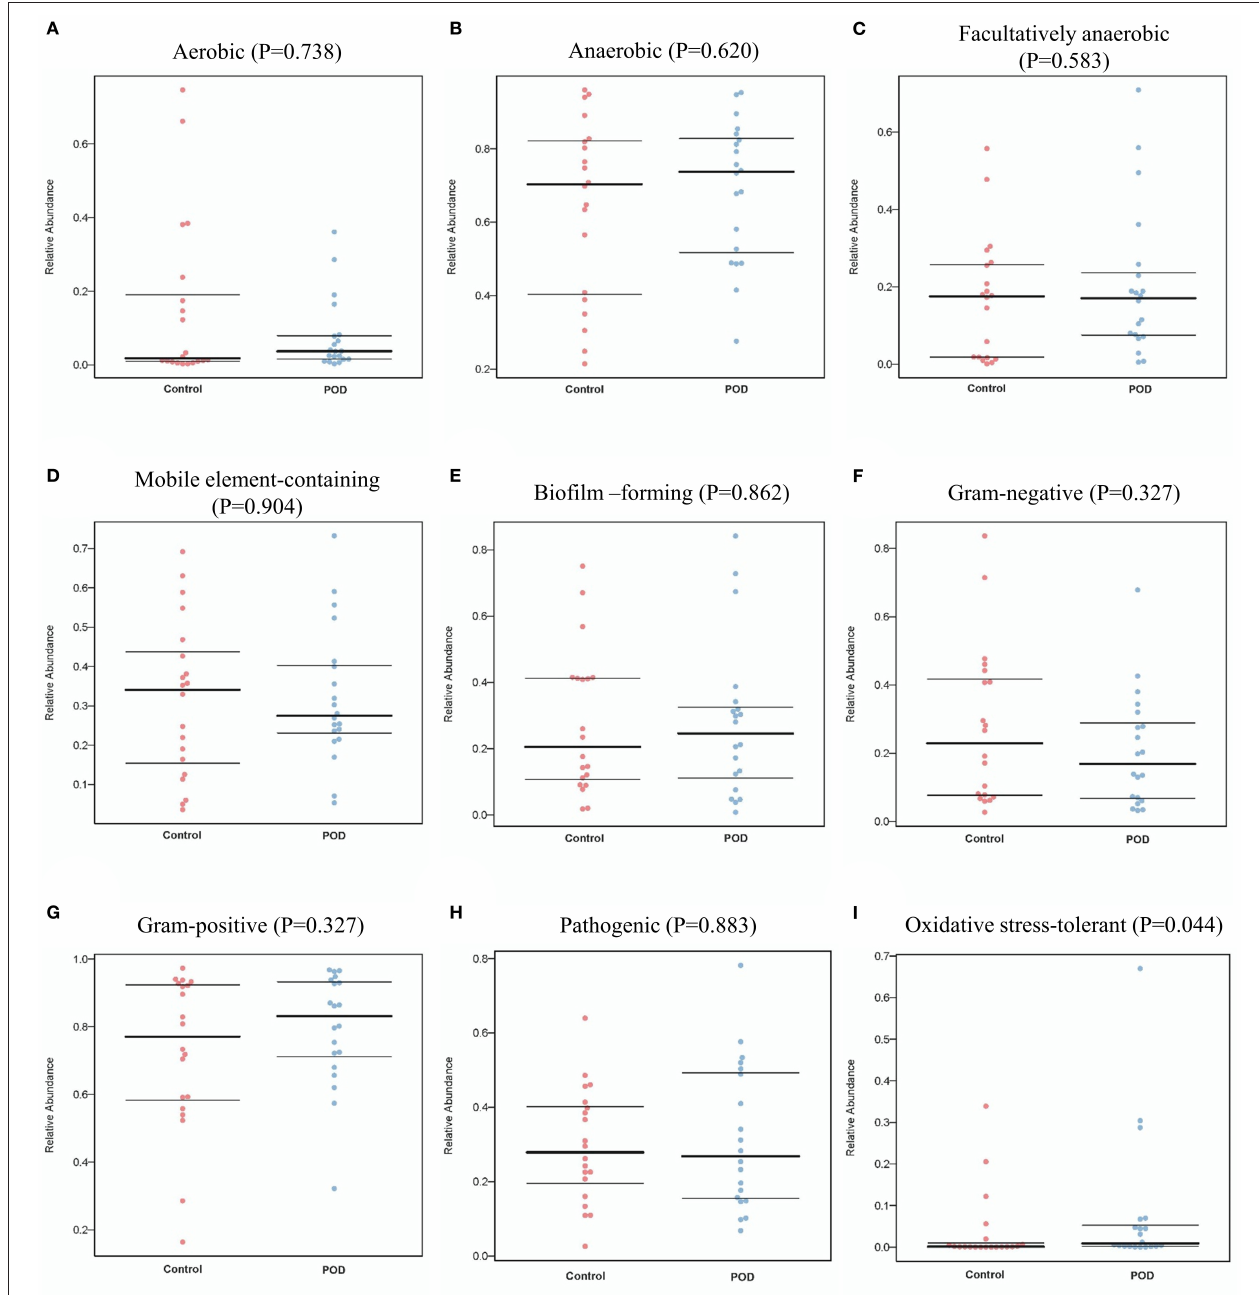
FIGURE 5 | Bacterial phenotype prediction for (A) Aerobic, (B) Anaerobic, (C) Facultatively anaerobic, (D) Mobile element-containing, (E) Biofilm-forming, (F) Gram-negative, (G) Gram-positive, (H) Pathogenic, and (I) Oxidative stress-tolerant.